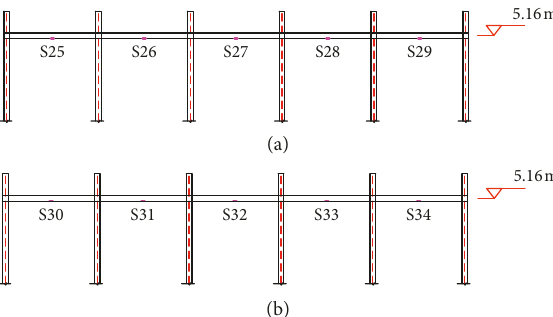
Figure 13: Layout of strain gauges on horizontal rods in Models 4 and 5. (a) A-axis horizontal beam. (b) C-axis horizontal